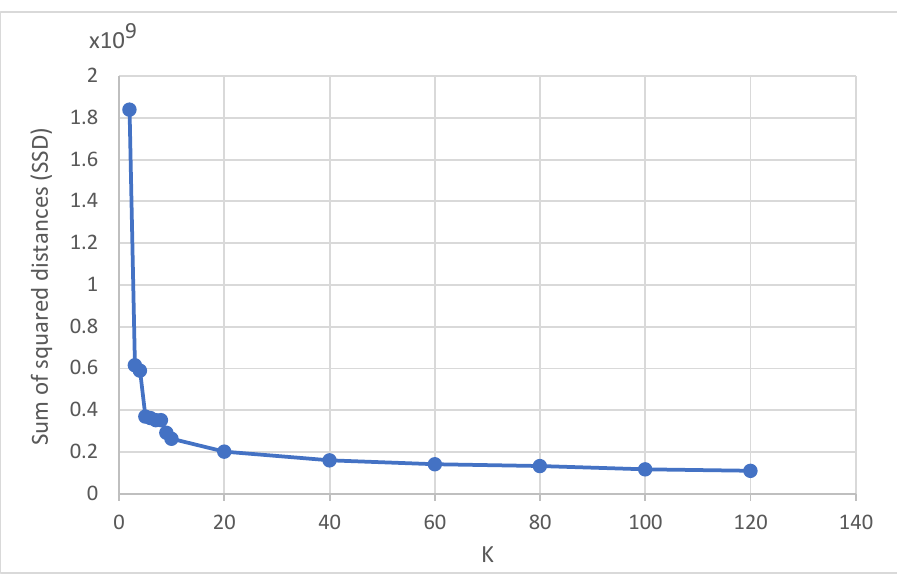
Figure 9. The “Elbow” curve, i.e., the 𝑆𝑆𝐷 cost vs. 𝐾 .